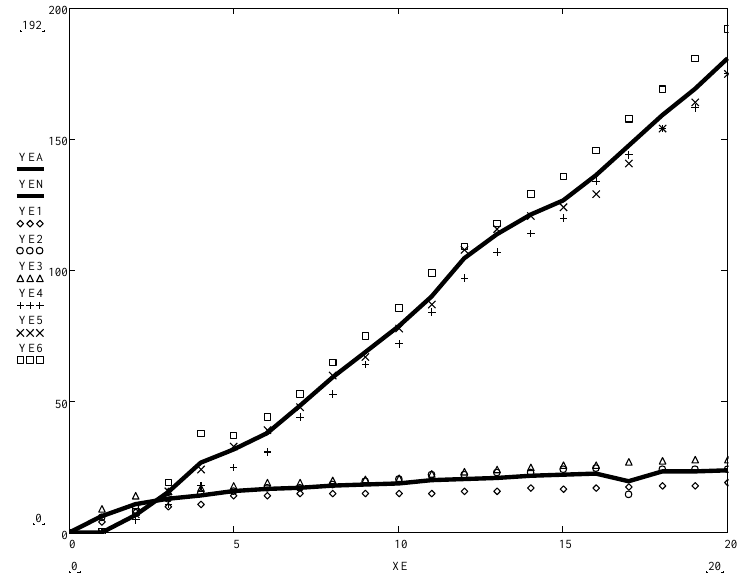
Fig. 4. Wear of nitrided (upper area) and non-nitrided samples (lower) due to the action of the mechanical component of friction (pressure 4 MPa, counterbody – VK8 hard alloy implanted by the electrospark method)